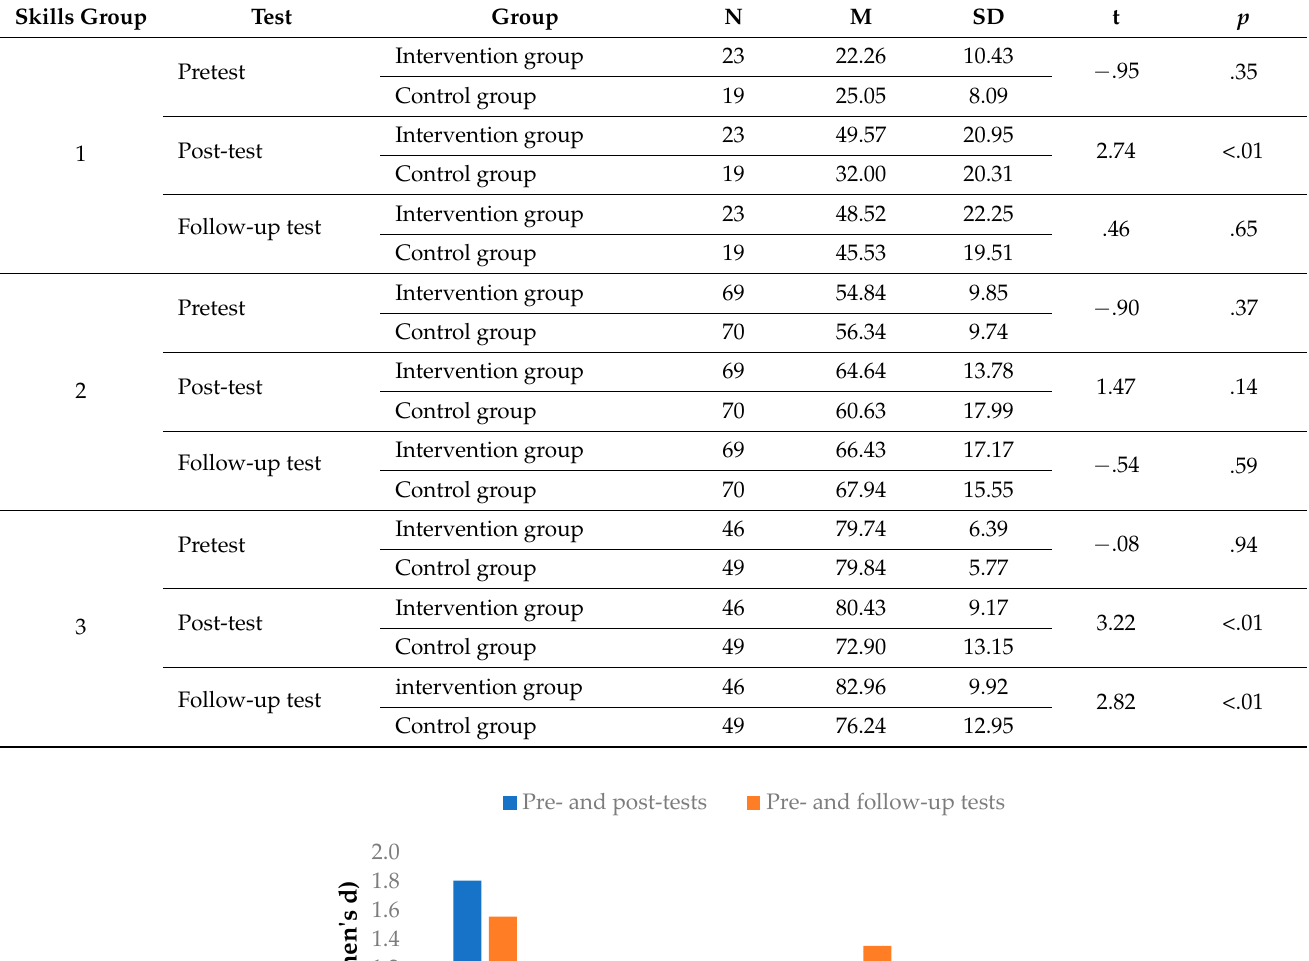
Table 3. Performance of students in the intervention and control groups according to the three skill groups on the pre-, post-, and follow-up tests.